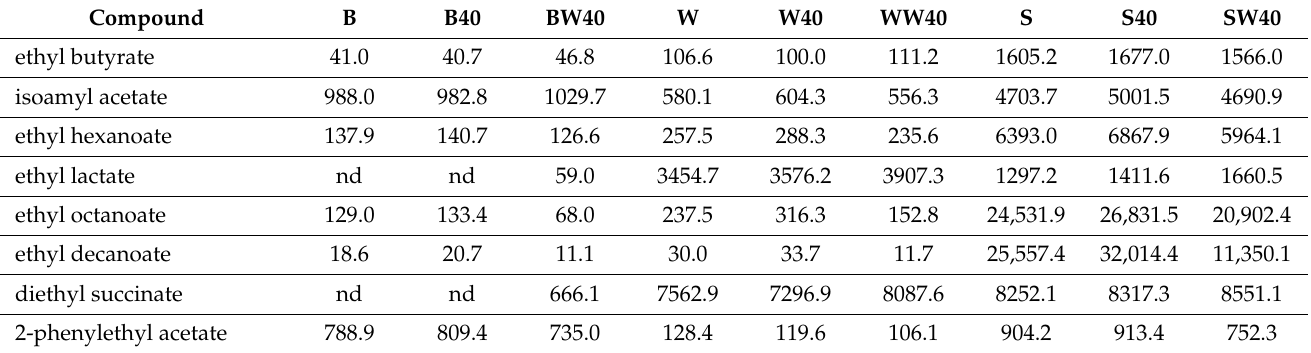
Table 4. Concentration [ µ g/L] of selected compounds in beer (B), wine (W), and grape marc spirit (S) in their initial states, after 48 h at 40 ◦ C without wood (B40, W40, S40), and after 48 h at 40 ◦ C with reused wood (BW40, WW40, SW40)